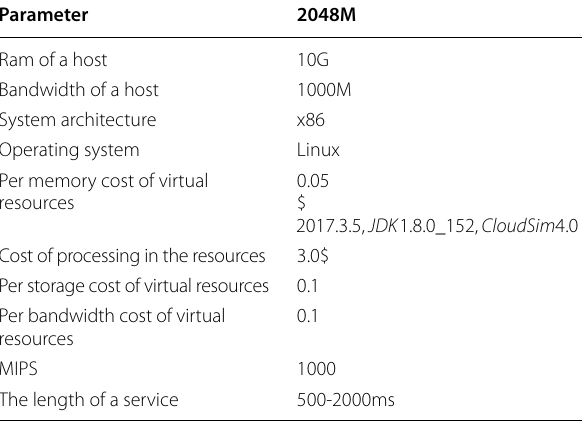
Table 3 The cloud platform simulation